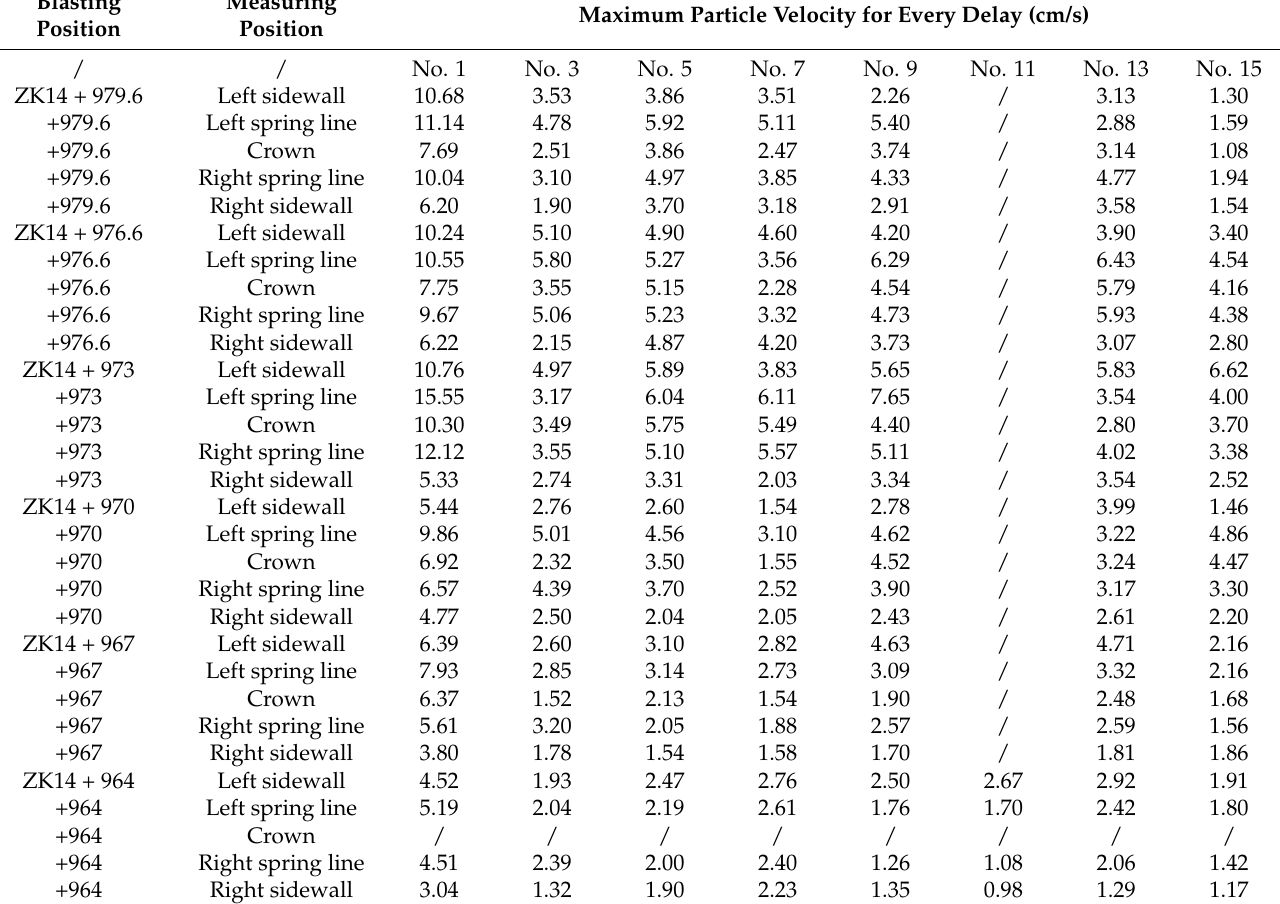
Table 2. Maximum particle velocity for every